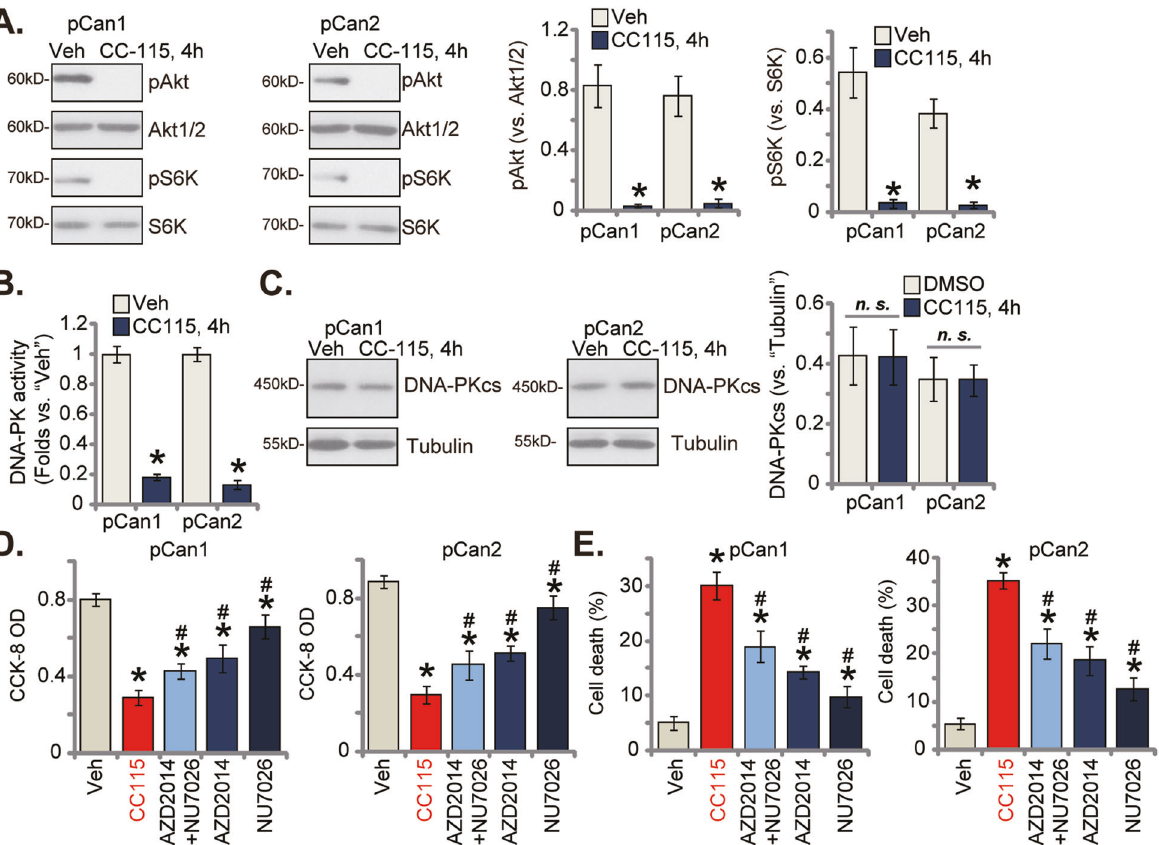
Fig. 4 CC-115 simultaneously blocks mTORC1/2 and DNA-PKcs activation. pCan1 or pCan2 cells were treated with CC-115 (100 nM), and cultivated for the designated time periods, expression of listed proteins was shown A , C ; The relative DNA-PK activity was measured as well B . pCan1 or pCan2 cells were treated with CC-115 (100 nM), AZD2014 (100 nM), NU7026 (100 nM) or AZD2014 plus NU7026, and cells were further cultivated for 96 h; Cell viability and death were measured via the CCK-8 D and the Trypan blue staining E assays, respectively. For each assay, n = 5. * P < 0.05 versus “ Veh ” group. # P < 0.05 versus “ CC-115 ” group. “ n.s . ” stands for non-statistical difference.